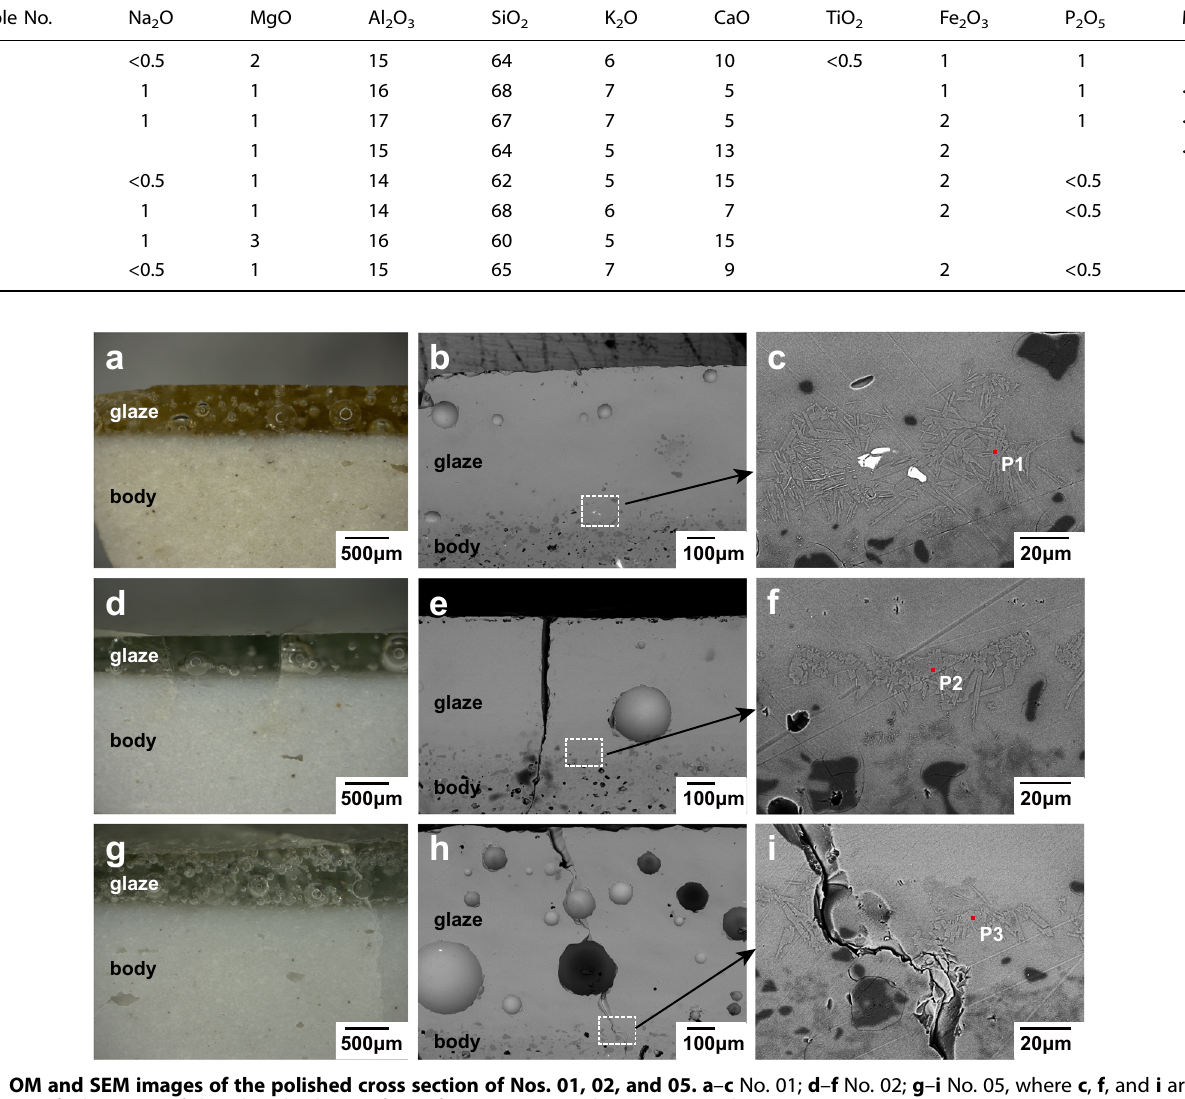
Fig. 1 OM and SEM images of the polished cross section of Nos. 01, 02, and 05. a – c No. 01; d – f No. 02; g – i No. 05, where c , f , and i are the local magni fi ed images of the glaze-body interface of Nos. 01, 02, and 05,